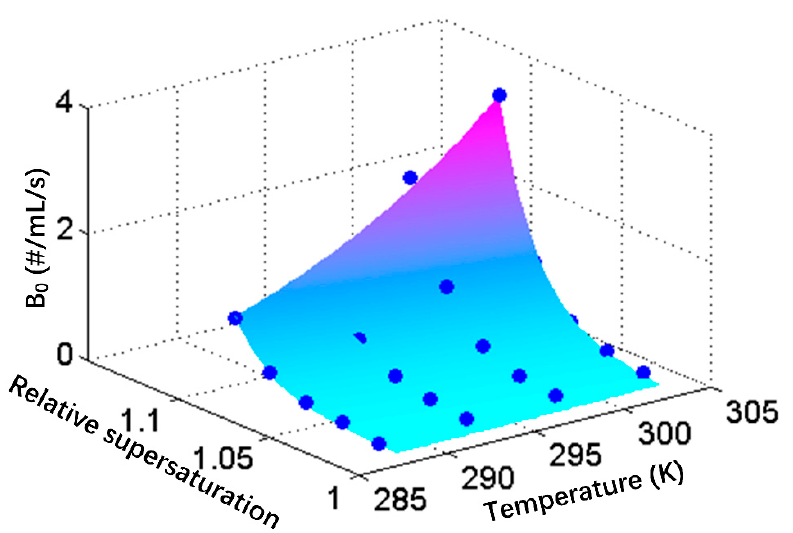
Figure 11. Fitted and measured secondary nucleation rates at a stirrer speed of 200 rpm.